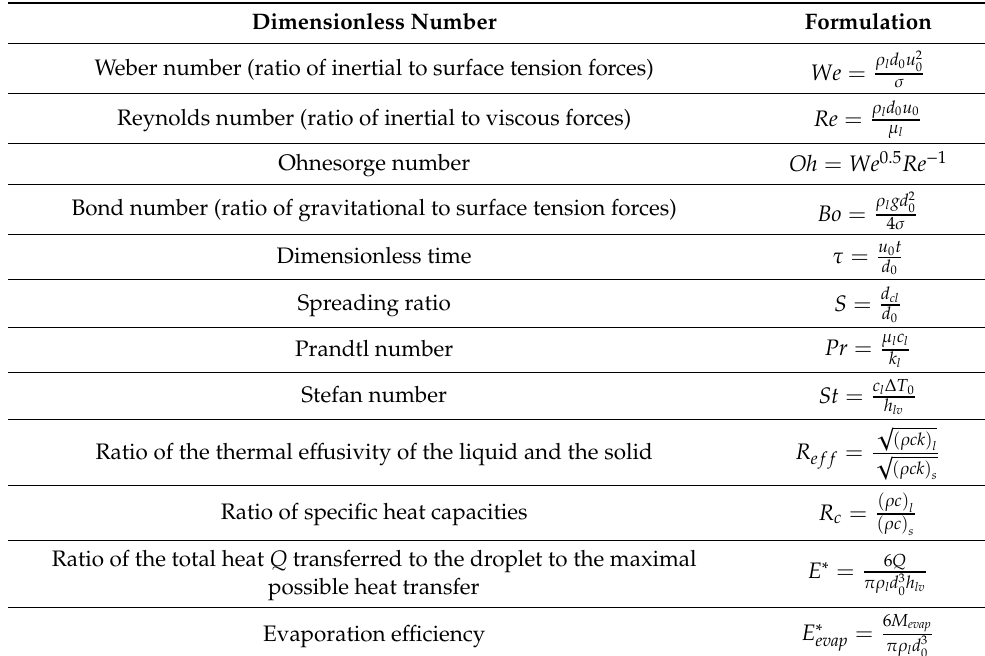
Table 1. Key dimensionless numbers to study droplet impact